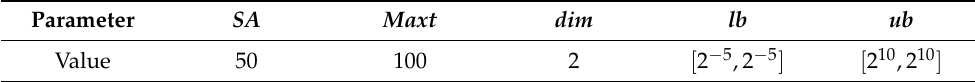
Table 7. The parameters related to the GWO optimization algorithm.